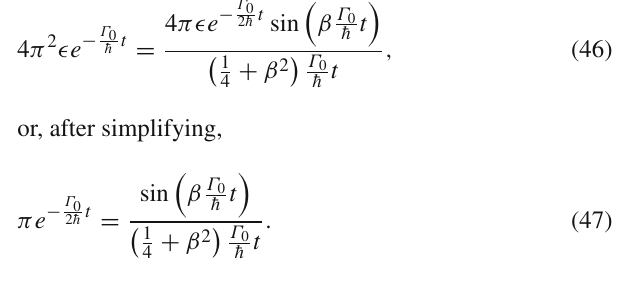
Fig. 3 The dependence ρ DE ( t ) (from Eq. (40)) for the best fit value of model parameter (see Table 1). The cosmological time t is expressed in s × Mpc . The present epoch is for t = 1 . 41 s × Mpc . Note that, in the 100 km 100 km is equal to Planck epoch, the value of ρ DE ( t Pl ) 3 H 2 0